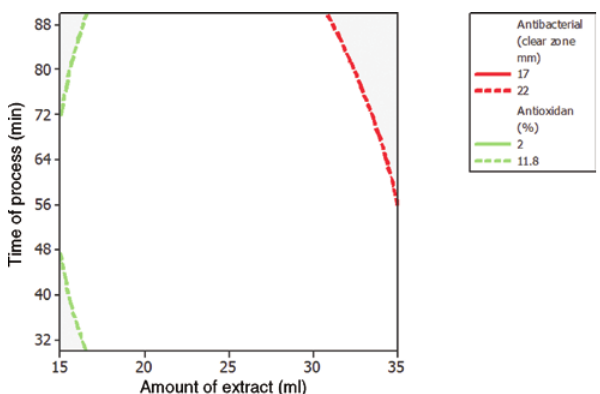
Figure 5: Overlaid contour plot of ZnO NPs’ antibacterial activity and antioxidant assay with acceptable levels as function of time and amount of extract.